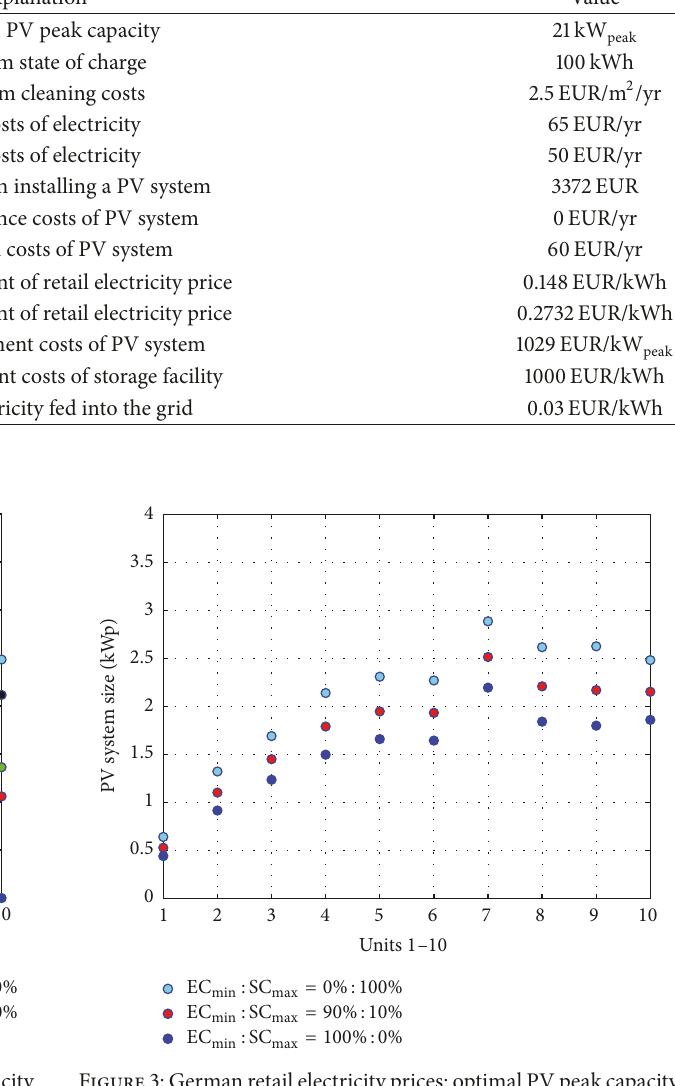
Figure 2: Austrian retail electricity prices: optimal PV peak capacity for the individual apartments calculated for different weighting of objective functions.